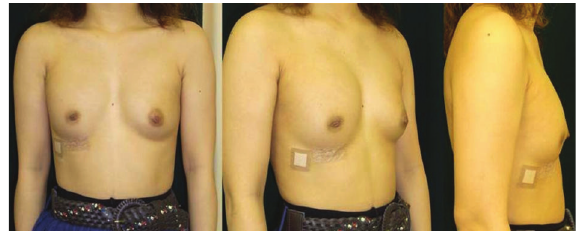
Figure 4: After expansion: the final volume of the tissue expander was 150mL.